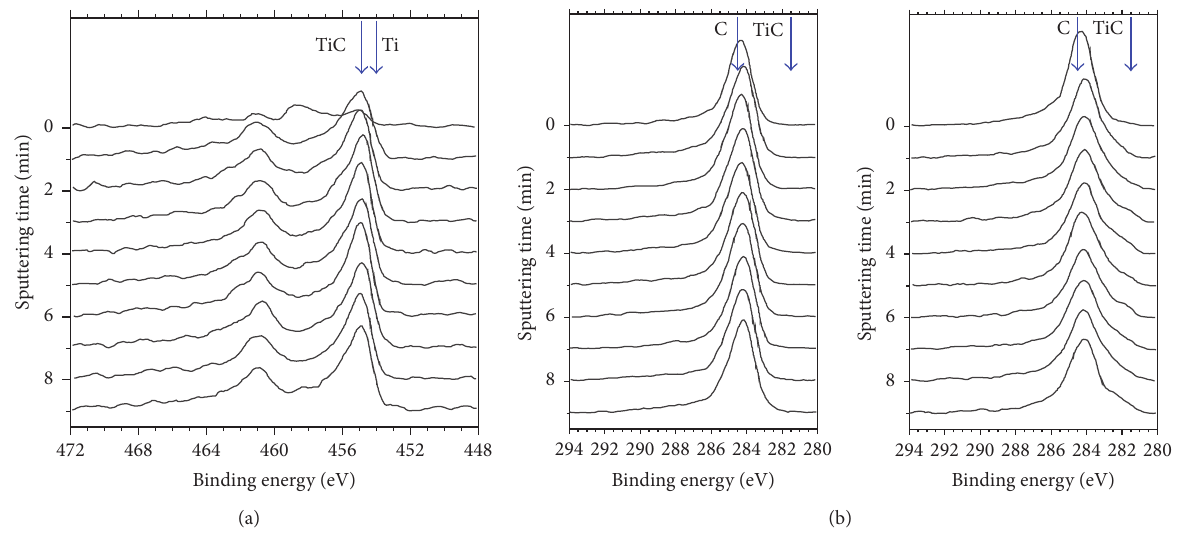
Figure 6: XPS spectra of (a) Ti2p of a Ti-DLC film with about 20 at.% Ti and (b) C1s of Ti-DLC films with 2 at.% (left) and 20 at.% (right) titanium content,